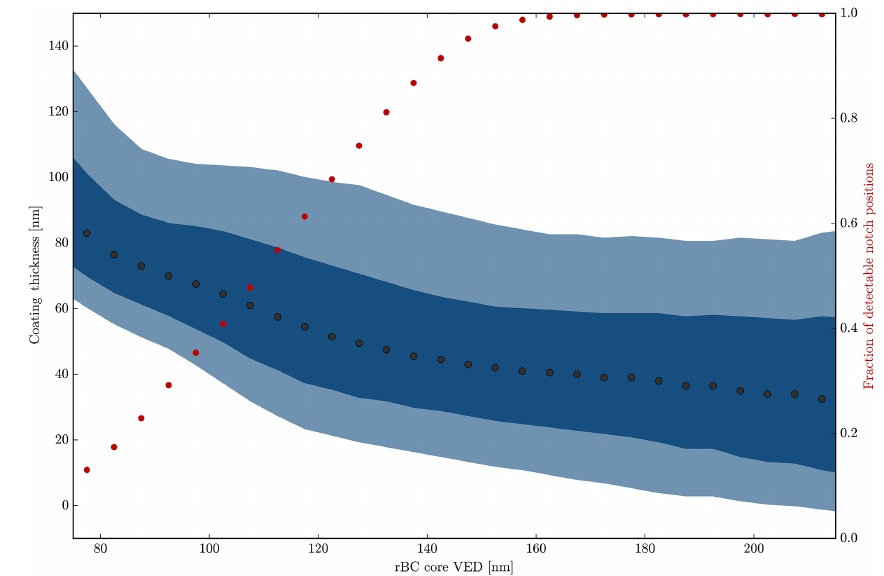
Figure 3. Coating thickness as a function of rBC core diameter. Grey markers are the median, dark shaded area is the 25th–75th percentile, lighter shaded area is the 10th–90th percentile of coating thicknesses for each